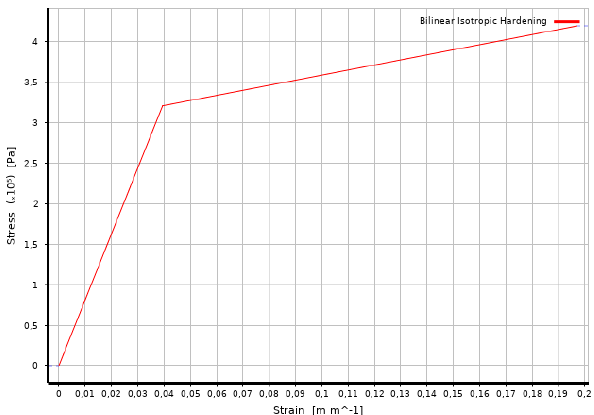
Figure 14. Theoretic diagram of a bilinear hardening model (from ANSYS).